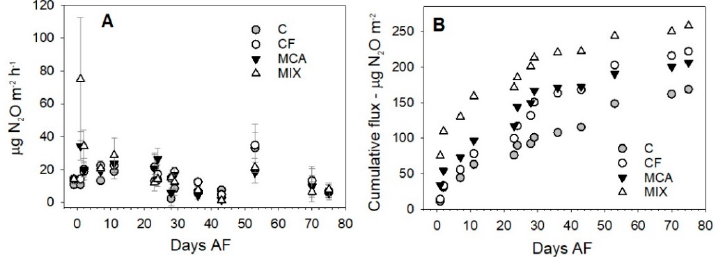
Figure 2. Soil CO 2 hourly emission (A) and cumulative flux (B) measured in the plots of the four treatments between 13 May and 25 July 2013. DAF stands for days after fertilization event (13 May 2013). Error bars represent one standard deviation (n = 12). Average N 2 O fluxes were quite low, varying between 1.4 and 34.4 μ g N 2 O m -2 h -1